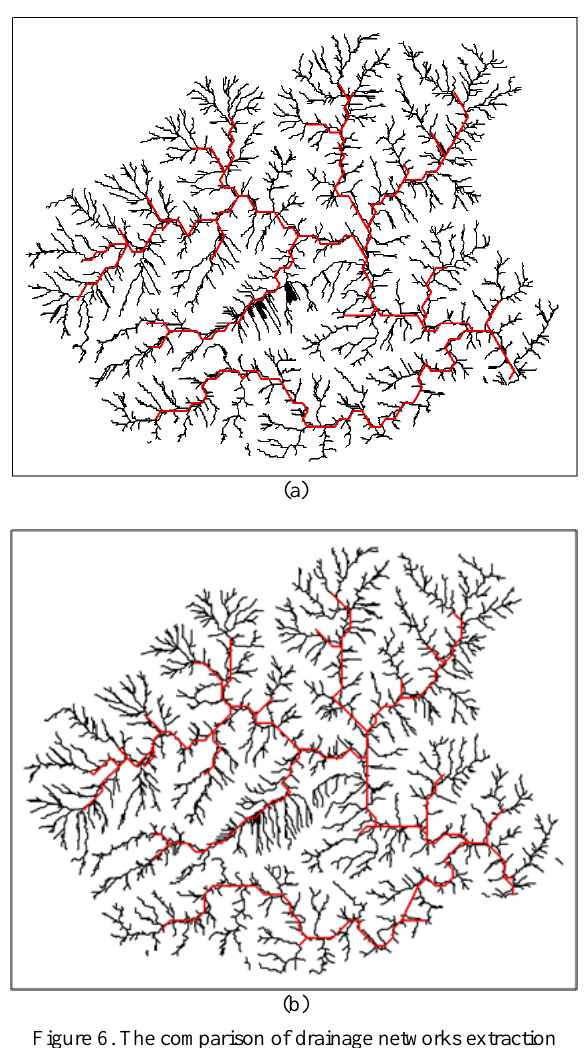
Figure 6. The comparison of drainage networks extraction results between hexagonal and square grid-based DEMs at 50m and 400m resolution: the black lines are extracted results at 50m resolution, the red lines are extracted results at 400m